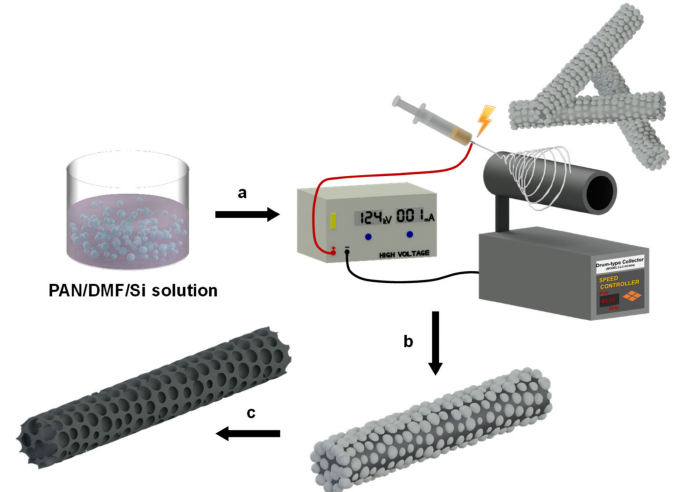
Figure 1. Schematic illustration of the fabrication process for porous carbon nanofibers (p-CNFs). The major steps of the fabrication process were: ( a ) Electrospinning the polyacrylonitrile (PAN) / silica solution using a metal drum collector. ( b ) Oxidation of the PAN / silica nanofibers in air at 260 ◦